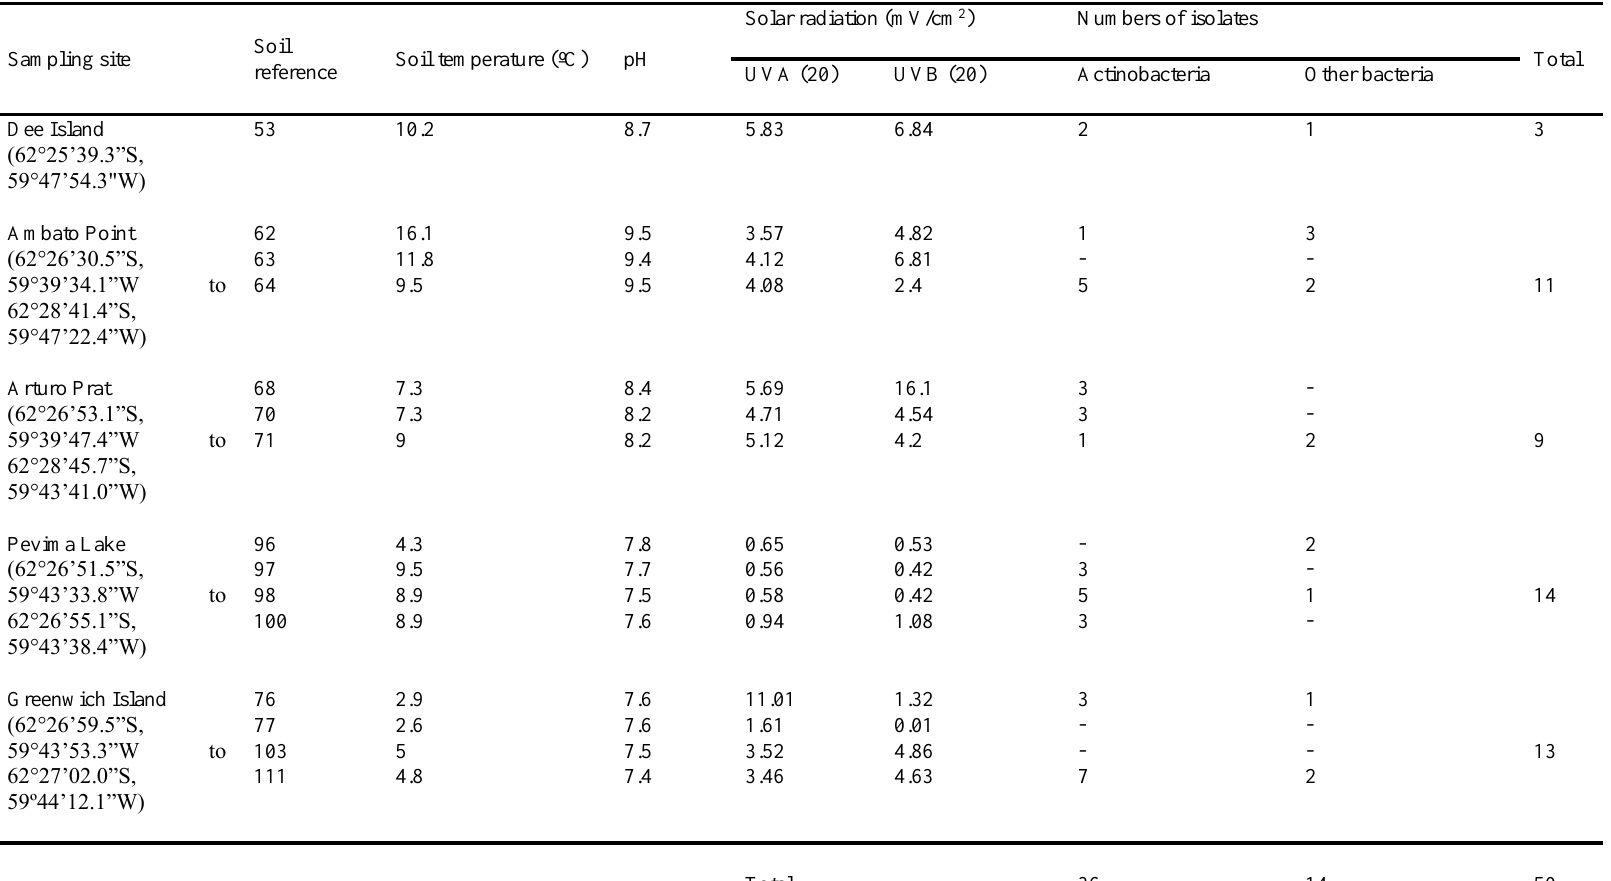
Table 1: Physical and chemical properties of soils and numbers of Actinobacteria and bacteria isolates from 15 soil